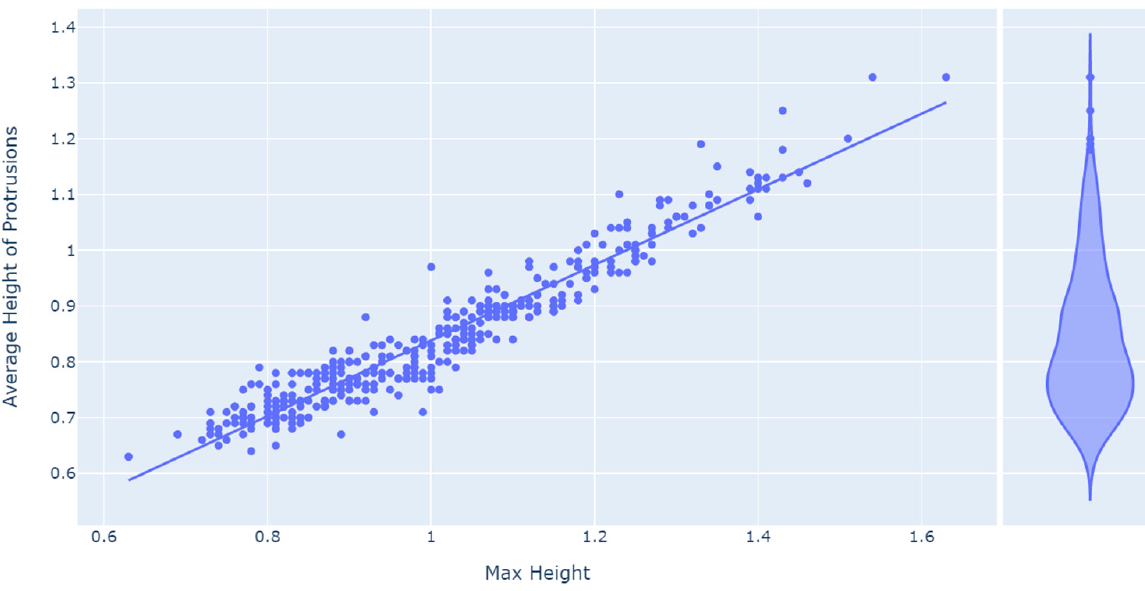
Figure 13. Scatter plot for average distance between protrusions and average number of protrusions. Figure 14. Scatter plot for shade and brightness.